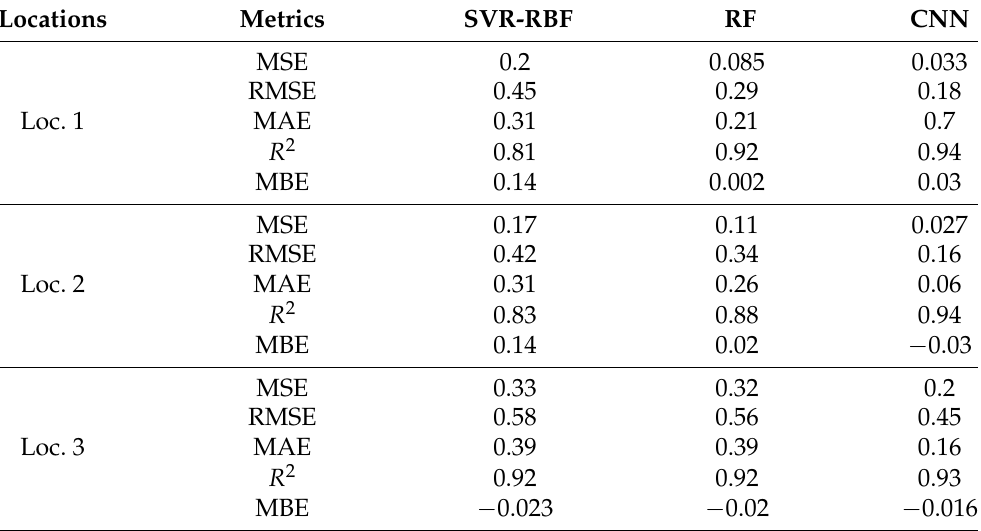
Table 11. Performance of the traditional machine learning algorithms and CNN model on the dataset